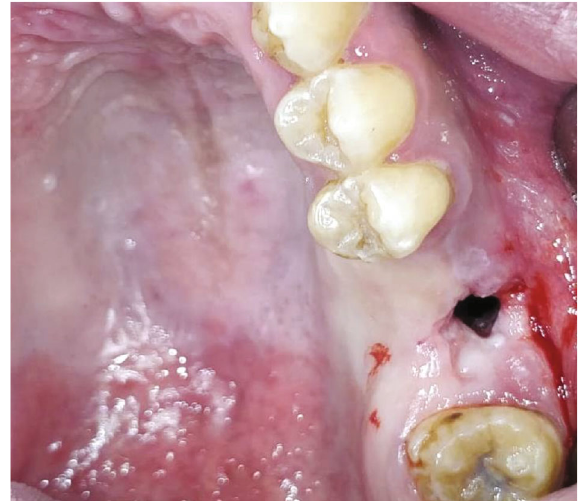
Figure 6: Intraoral view showing a left maxillary OAC of 7mm diameter.